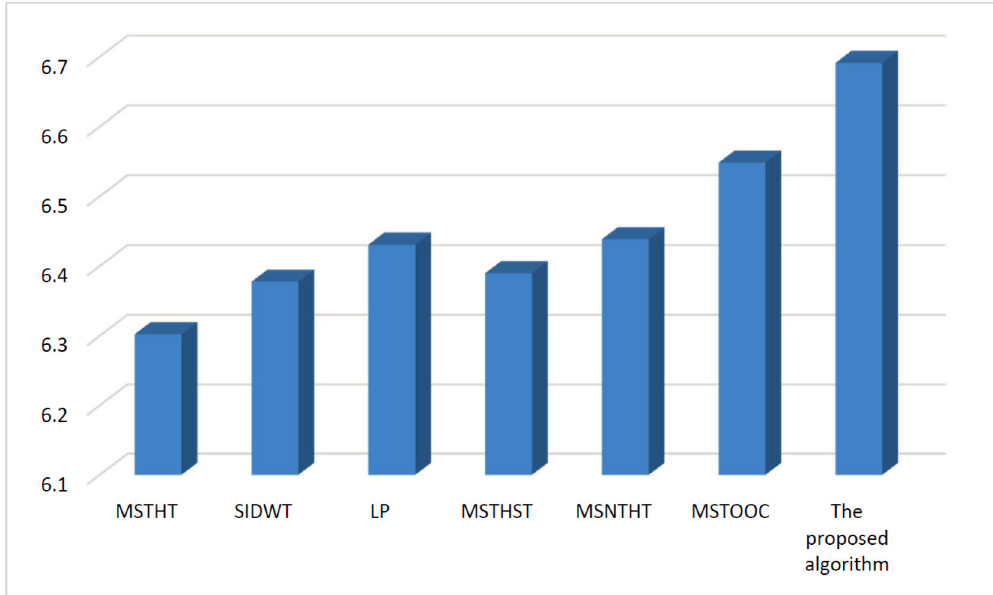
Figure 4. Quantitative comparison using measure entropy.